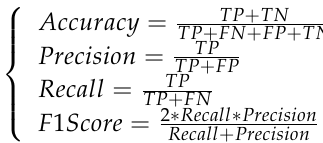
Figure 9. Final process objects and their evolution relationships of the simulated datasets.